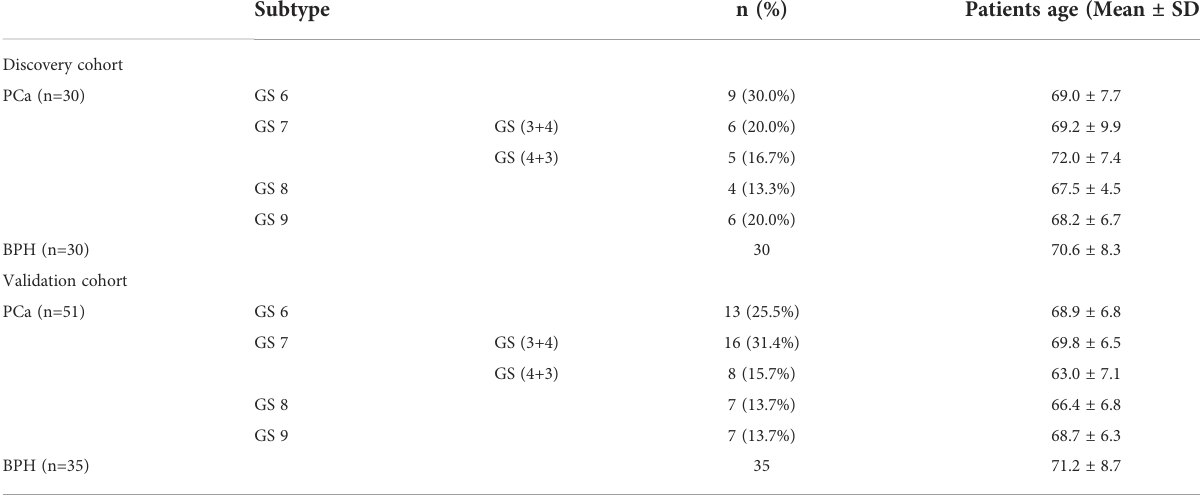
TABLE 1 Clinical characteristics of serum samples in this